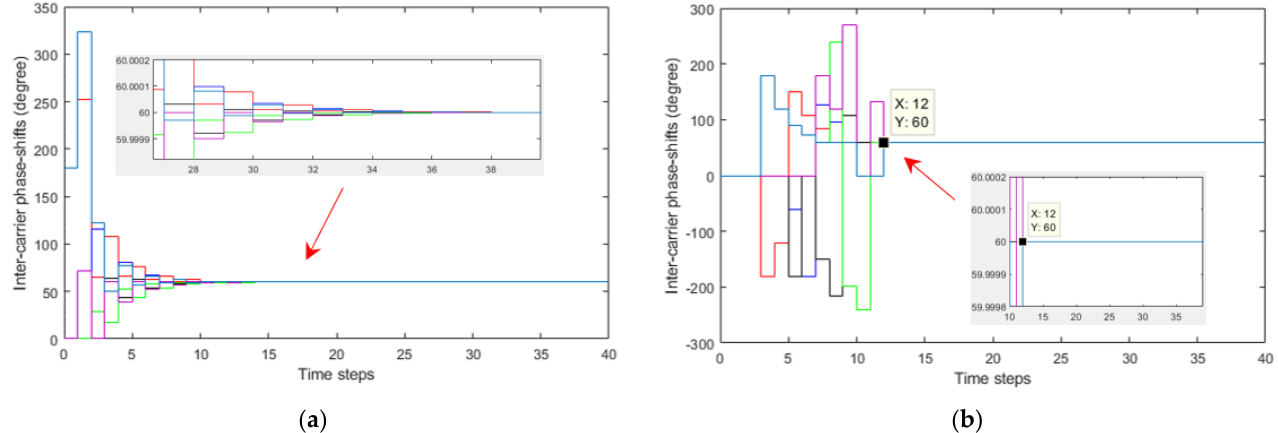
Figure 25. The inter-carrier phase-shifts of a converter with six-carriers, startup with ( a ) conventional modified updating rule; ( b ) proposed DSA-PSC.